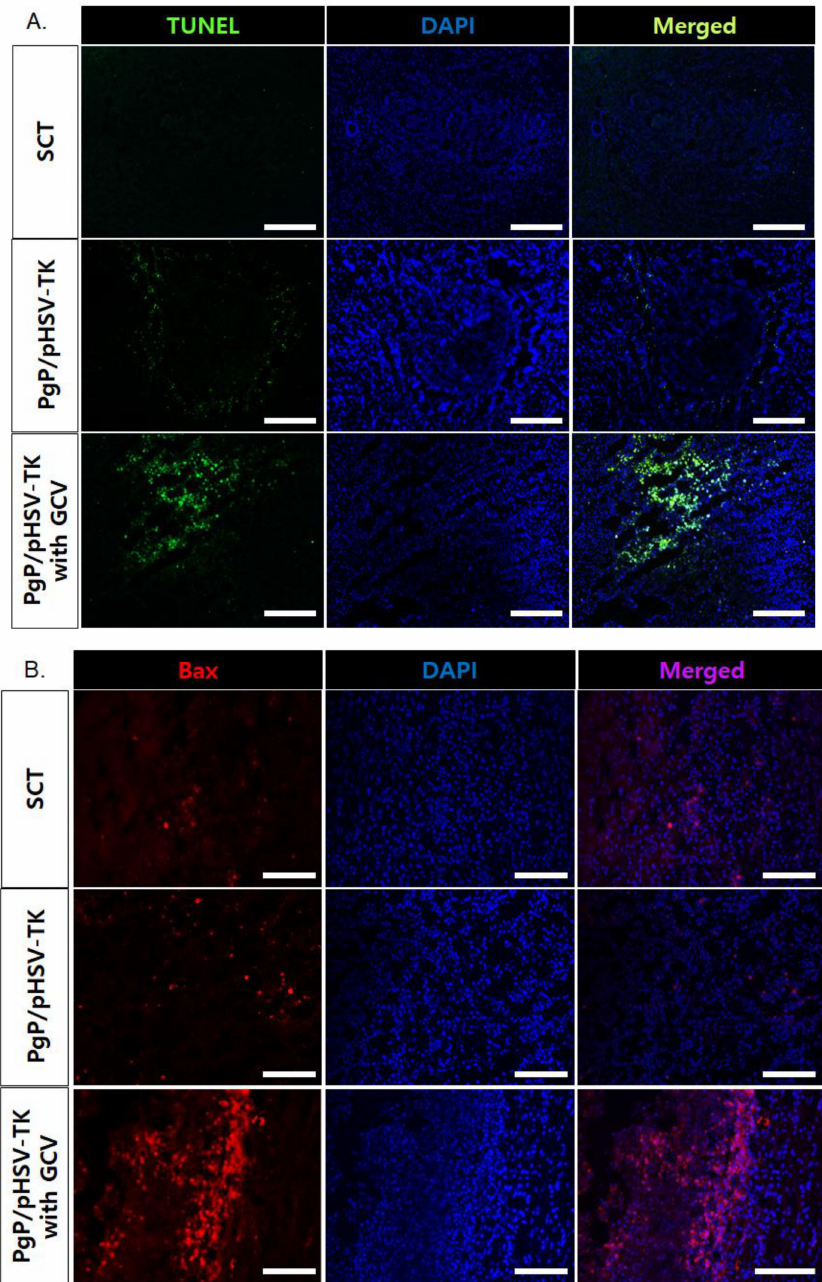
Figure 8. Representative images of ( A ) TUNEL + cells (green), ( B ) Bax + cells (red), in spinal cord tumor at 10 days post-intratumoral injection of PgP / pHSV-TK (10 µ g pHSV-TK, N / P ratio of 60 / 1) polyplexes with GCV (40 mg / kg, intraperitoneal injection). Cell nuclei were counter stained with DAPI (blue). Scale bars indicate 100 µ